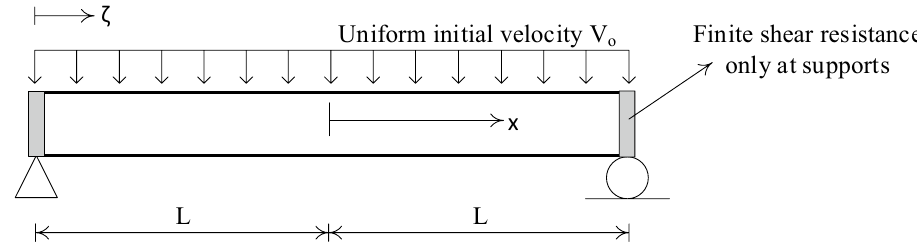
Figure 14. Impulsively loaded simply supported beam including finite shear resistance at the support